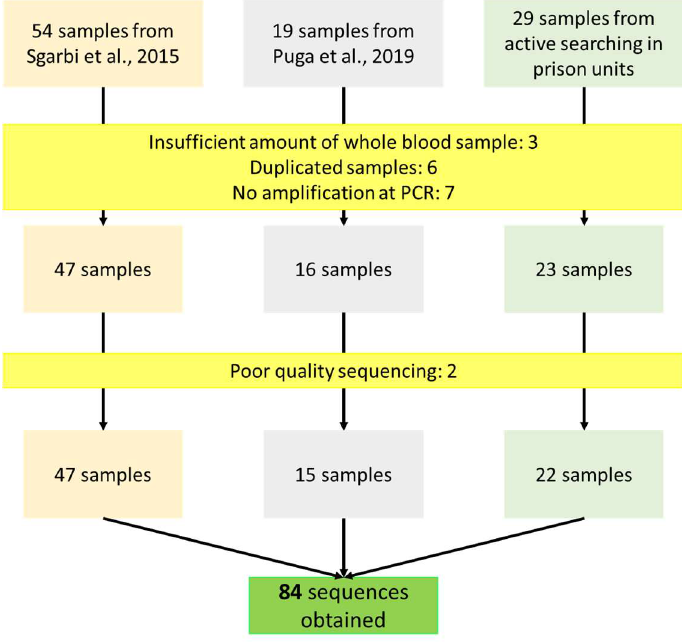
Figure 1. Flowchart of obtaining HIV-1 sequences from infected prisoners in this